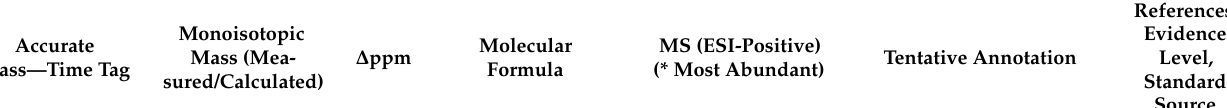
Table 1. Annotation of HPLC–QTOF-MS